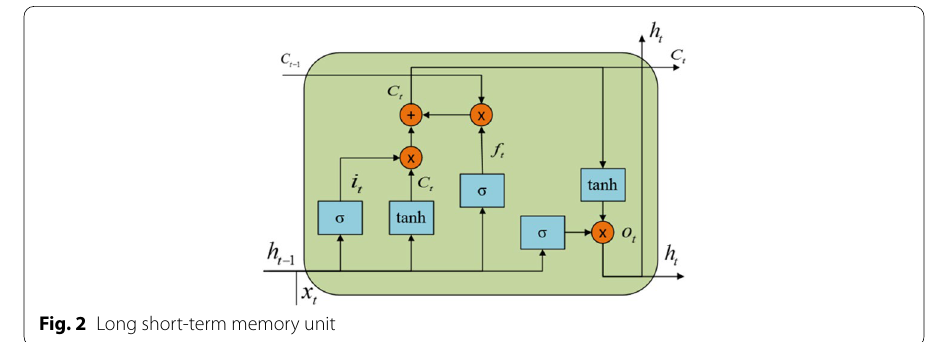
Fig. 2 Long short-term memory unit